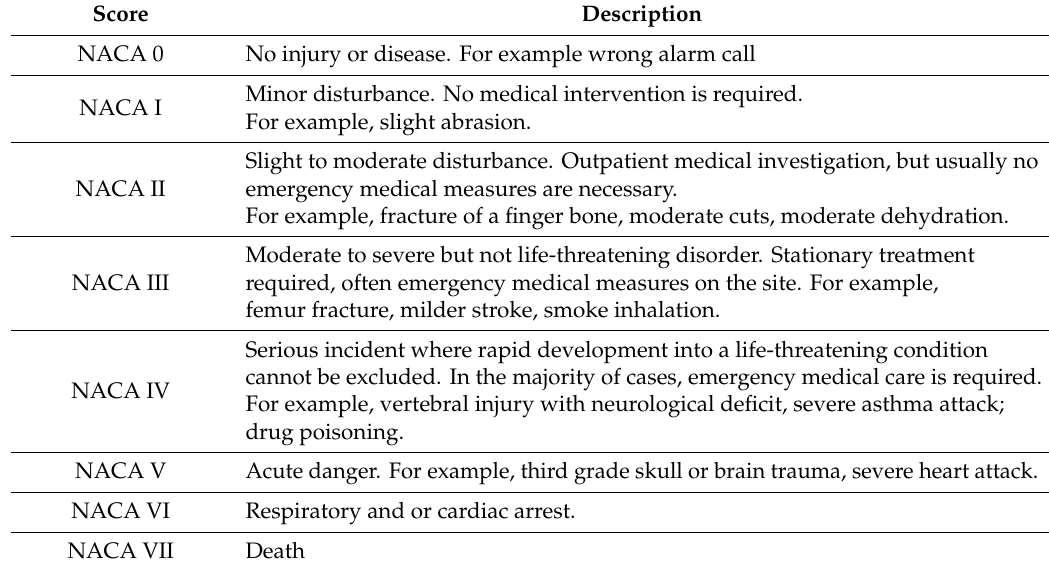
Table 1. NACA-Score (National Advisory Committee for Aeronautics Score)